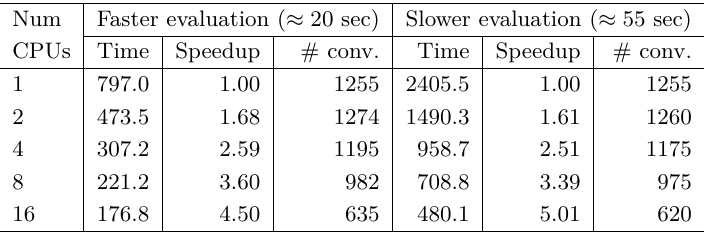
Table 4 Shifted geometric mean of the wall-clock time to converge to an optimal solution.